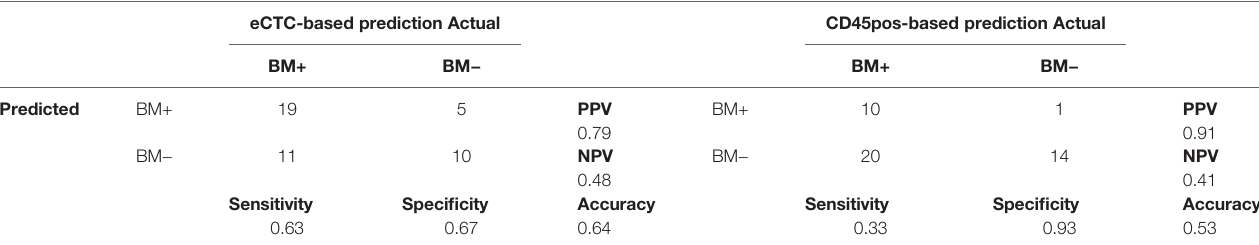
TABLE 4 | Contingency tables of prediction of bone metastasis based on a single variable derived from either eCTC (left) or CD45-positive cells